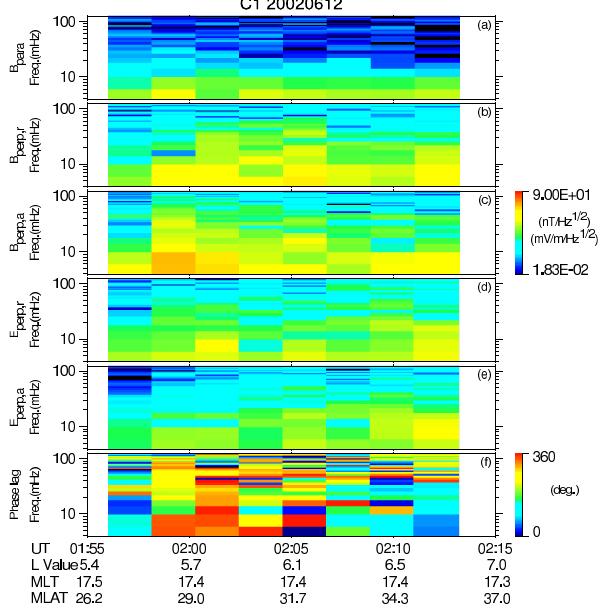
Fig. 9. Frequency-time spectra calculated using C1 data between 01:55 and 02:15UT on 12 June 2002. Each panel shows (a) – (c) magnetic field spectra for three components, (d) – (e) electric field spectra for two perpendicular components and (f) phase lag between radial magnetic fluctuations and azimuthal electric fluctu- ations. Spacecraft locations are noted in the bottom of the figure.